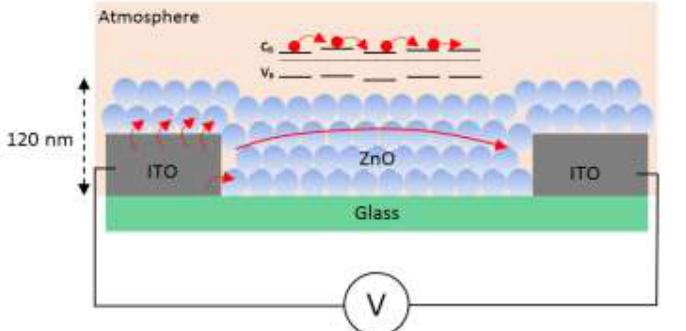
Figure 1: A two-dimensional schematic of the solution-processed ZnO UV photodetector is employed in this work. It shows how electrons are injected into the ZnO nanoparticles from the electrode. Electron transport through hopping between particles is shown in the inset.